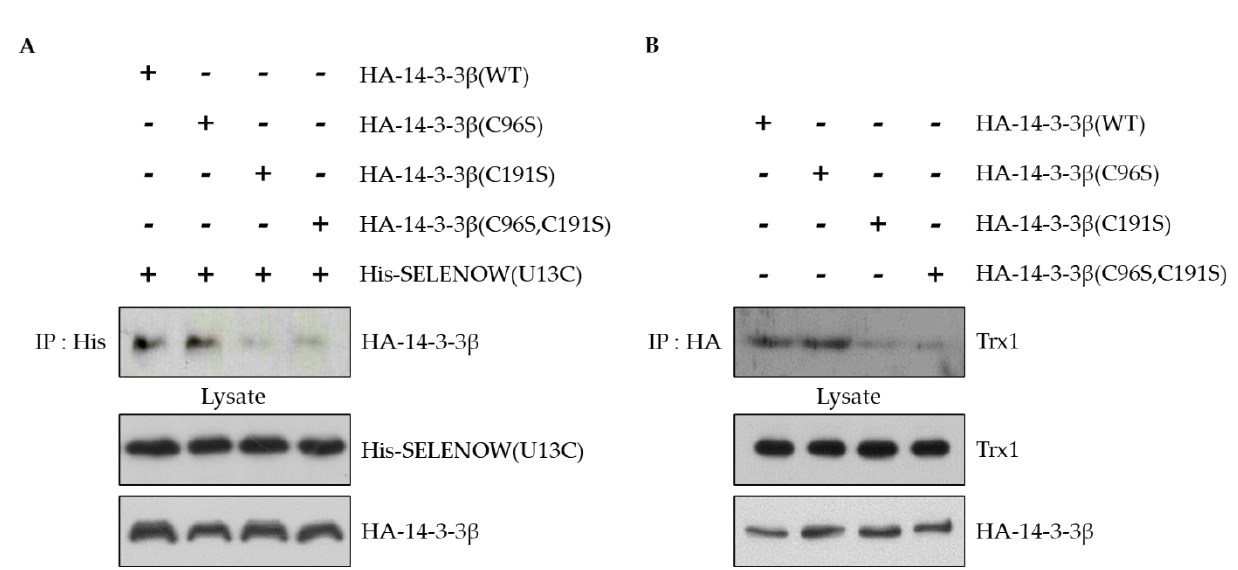
Figure 2. The Cys191 residue of 14-3-3 β interacts with SELENOW and Trx1. ( A ) HEK293 cells were co-transfected with His-SELENOW(U13C) and HA-14-3-3 β (WT, C96S, C191S or C96,191S). The cell extracts were immunoprecipitated with anti-His antibody, and immunoblotting was performed with anti-HA and anti-His antibodies. ( B ) HEK293 cells were co-transfected with HA-14-3-3 β (WT, C96S, C191S or C96,191S). The cell extracts were immunoprecipitated with anti-HA antibody and immunoblotted with anti-Trx1 antibody or anti-HA antibody. The data were obtained from three independent experiments.